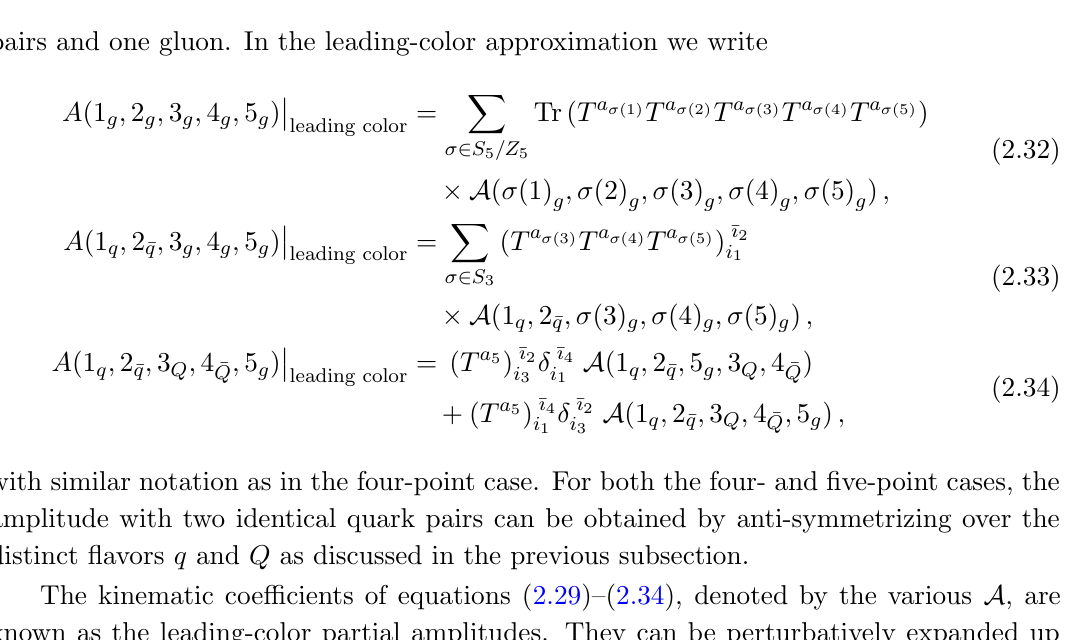
, N 1 and N 2 f f f